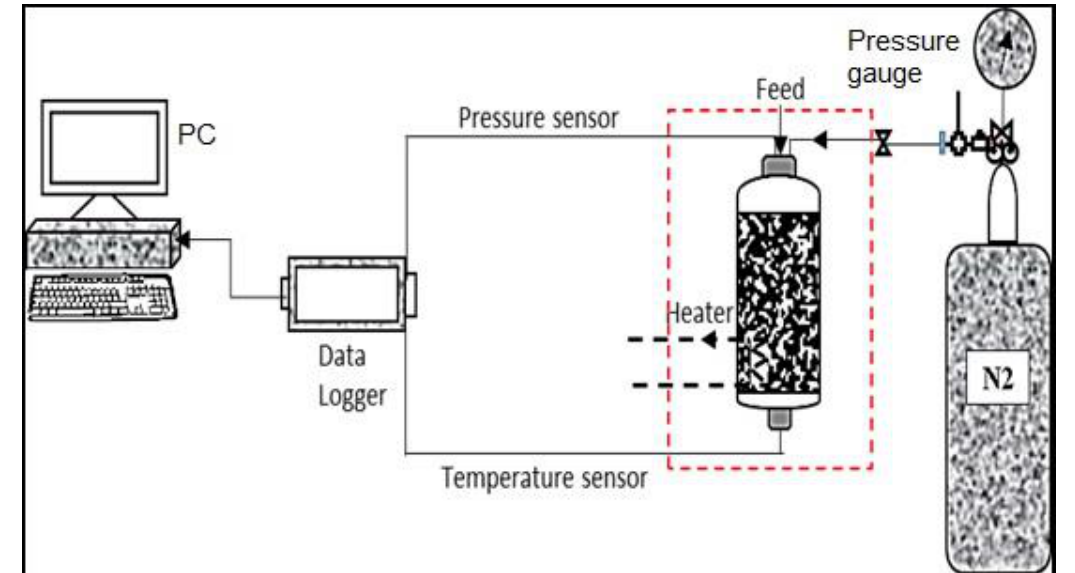
Figure 2. Experiment setup for monitoring thermochemical process.